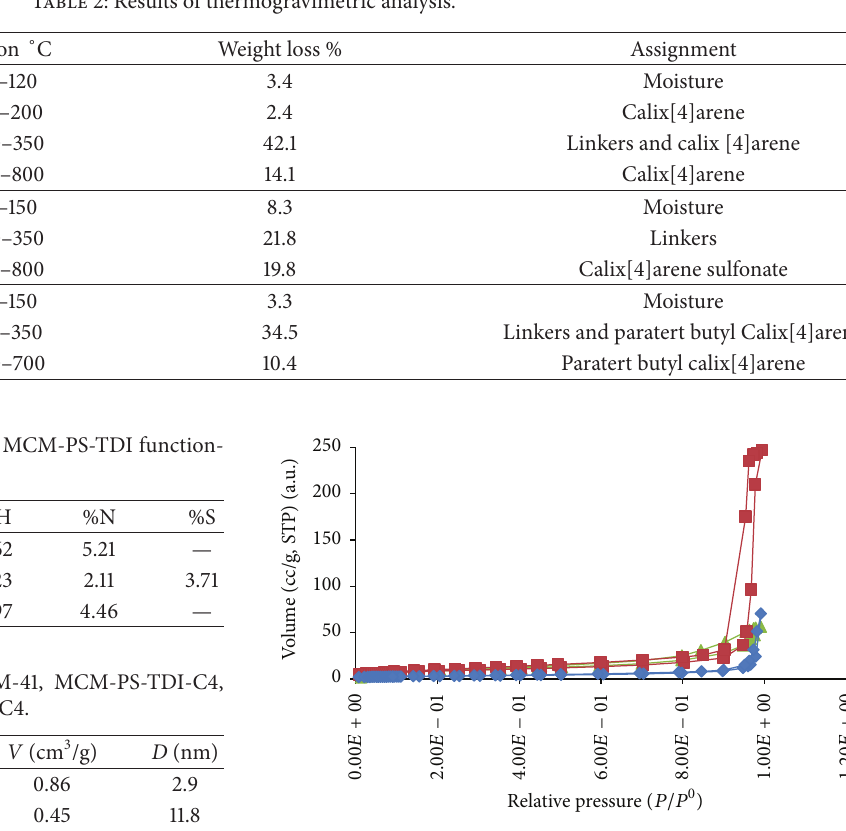
Figure 6: Nitrogen adsorption-desorption isotherms of